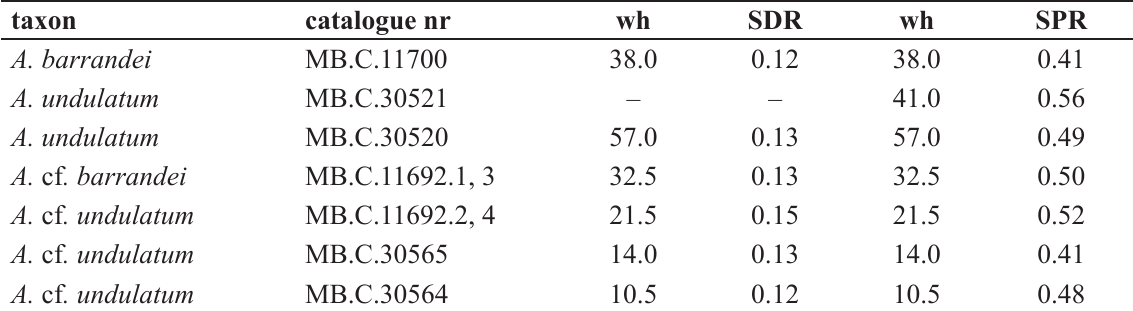
Table 6. Siphuncular diameter ratio (SDR) and siphuncular distance ratio (SPR) at their corresponding whorl height in specimens of Ancistroceras Boll, 1857.